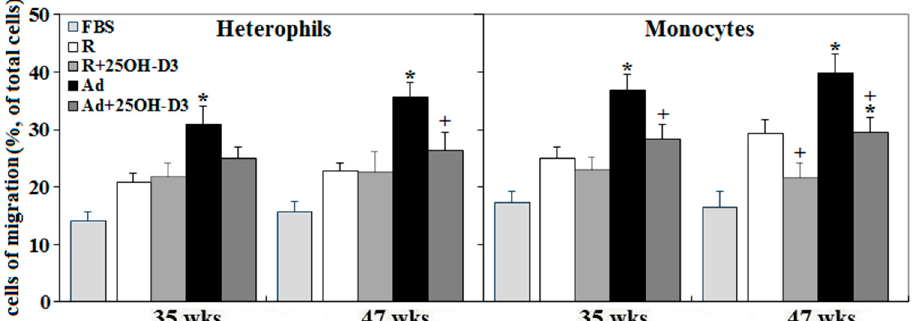
Figure 3. Effects of dietary 25-hydroxycholecalciferol supplementation on cardiac chemoattraction of broiler breeder hens provided with restricted or ad libitum feed intake. Four hearts from collections at 35 and 47 wks were used as a chemoattractant for leukocyte migration analysis through the trans-well method. Fetal bovine serum (FBS) served as a reference. Isolated leukocytes were pooled from 2 R-hens at age of 35 or 47 wks. *; significant difference by Ad-feed intake (vs. corresponding R hens, p < 0.05). +; significant difference by 25-OH-D3 inclusion (vs . R or Ad hens, p < 0.05). R; restriction, Ad; ad libitum.